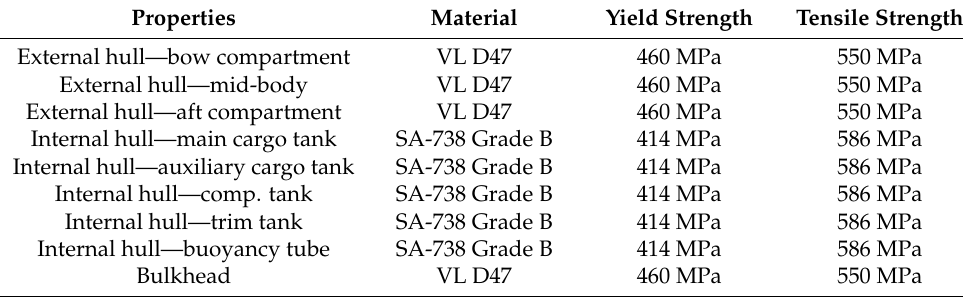
Table 2. SST structural design